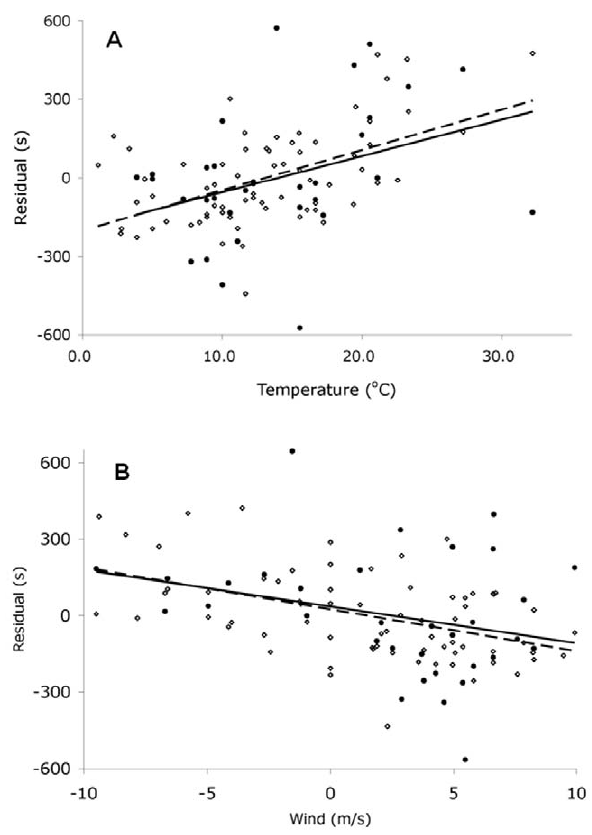
Figure 4. Likelihood of detecting a change in winning times for (A) men and (B) women. Lines show percent of experimental data sets (based on 1000 trials) that showed a significant change ( P , 0.05) in winning times for five consecutive years for each warming scenario. Each experimental data set began with 0.017 u C/yr warming until 2006. After 2006, the each warming scenario maintained a different rate of warming until 2100: 0.017 u C/yr (solid lines), 0.028 u C/yr (dashed lines), and 0.058 u C/yr (dotted lines). Men’s data started in 1933. Women’s data began in 1972.